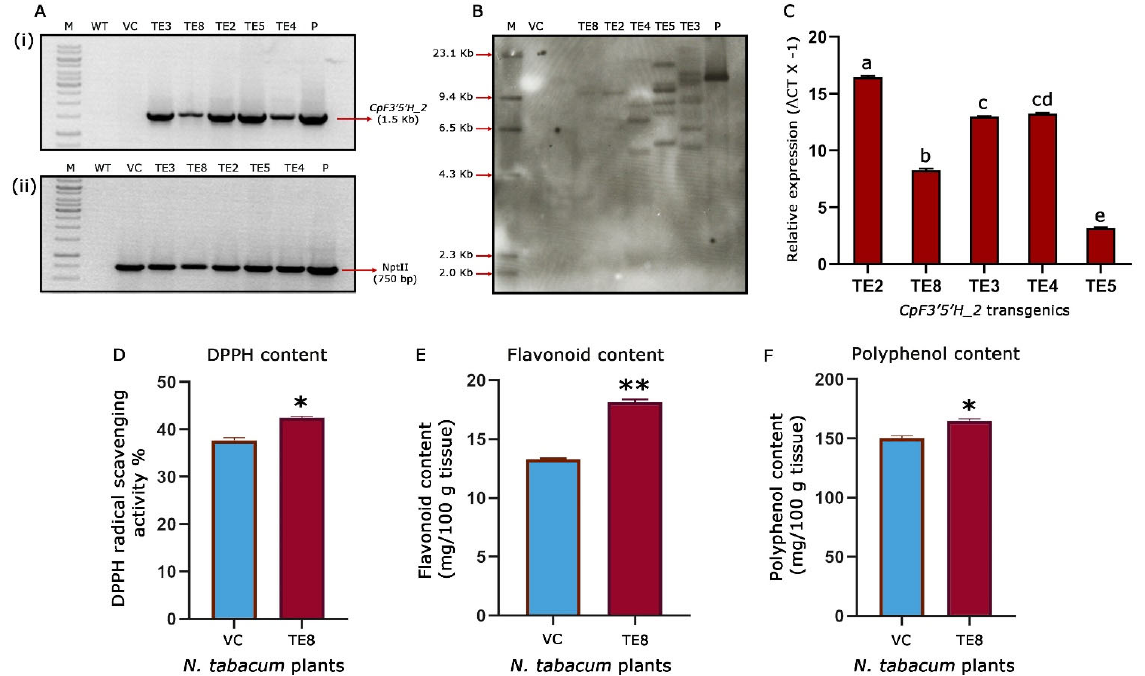
Figure 6. Molecular and biochemical characterisation of transgenic tobacco plants. ( A ) PCR analysis of selected transgenic, wild type and vector control plants (i) amplification of 1.5 kb CpF3 ′ 5 ′ H_2 gene fragment in selected transgenic tobacco plants; (ii) amplification of 750 bp nptII gene fragment